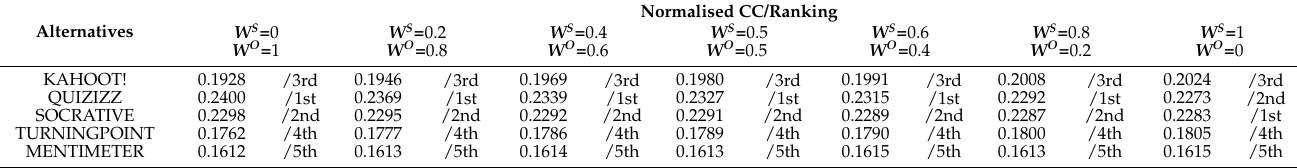
Normalised CC/Ranking